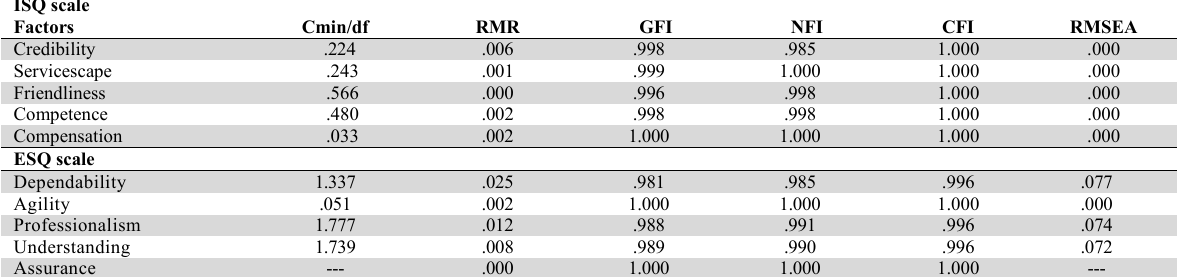
Key fit Indices for measurement model of ISQ and ESQ scale ISQ scale Factors Cmin/df RMR GFI NFI CFI RMSEA Credibility .224 .006